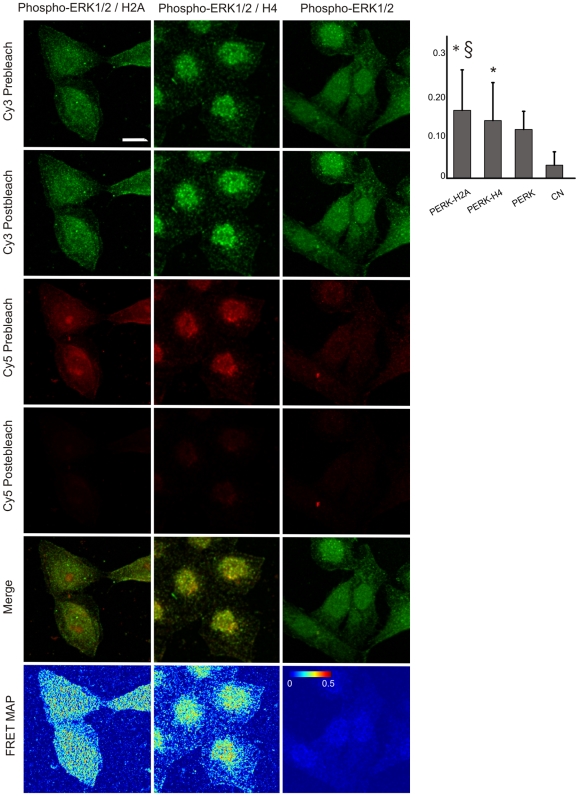
Endogenous ERK1/2 interaction with histones.HeLa cells fixed and stained against phospho-ERK and histones. Secondary antibodies conjugated to Cy3 and Cy5 respectively. Cy3 and Cy5 images prior and after Cy5 photobleaching, a merge image of Cy3 and Cy5 prior to photobleaching and a FRET map in accordance with Eq. 1 are shown. Bar = 10 µm. Color bar = FRET efficiency. Control for specificity of ERK-histones interaction: HeLa cells labelled with antibody to phospho-ERK and both secondary antibodies (PERK); representative images are shown. Negative FRET control: HeLa cells labelled for phospho-ERK and secondary Cy3 antibody (CN). Mean FRET efficiency shown in the bar graph on the upper right side; *p<0.5 respect to negative control and §p<0.5 with respect to specificity control (ANOVA and Scheffé test).